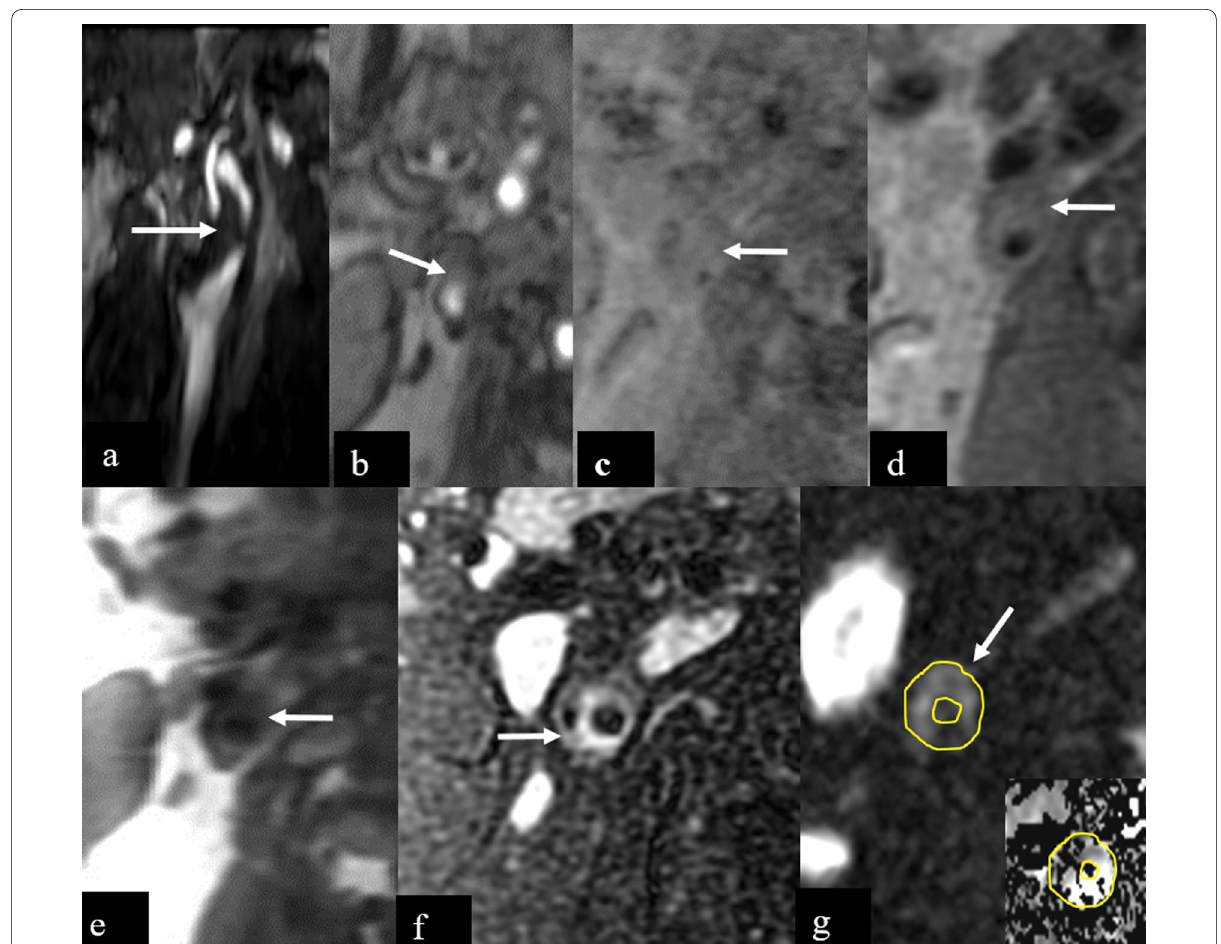
Fig. 3 Carotid MR images of a 65-year-old male with left hemiparesis, who was detected to have right ICA 80% stenosis (arrows). His NIHS at admission was 6, with a total of 2 cerebrovascular events before surgery. TOF images ( a , b ) showing right ICA stenosis with axial TOF showing a largely preserved periluminal dark band indicative of intact fibrous cap. T1 image ( c ) showed mildly increased signal with T2 ( d ) and PD ( e ), showing the plaque to have largely similar intensities. T2 FS ( f ) also showed the luminal stenosis with DWI image ( g ) with an ADC value of 1.290 (inset in